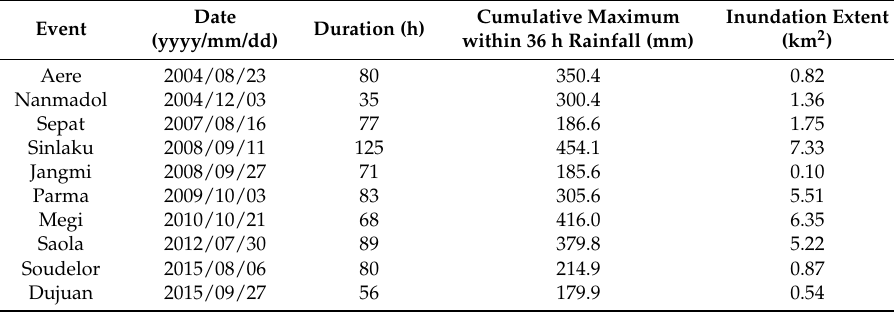
Table 1. Hydrological and inundation data for typhoons from 2004 to